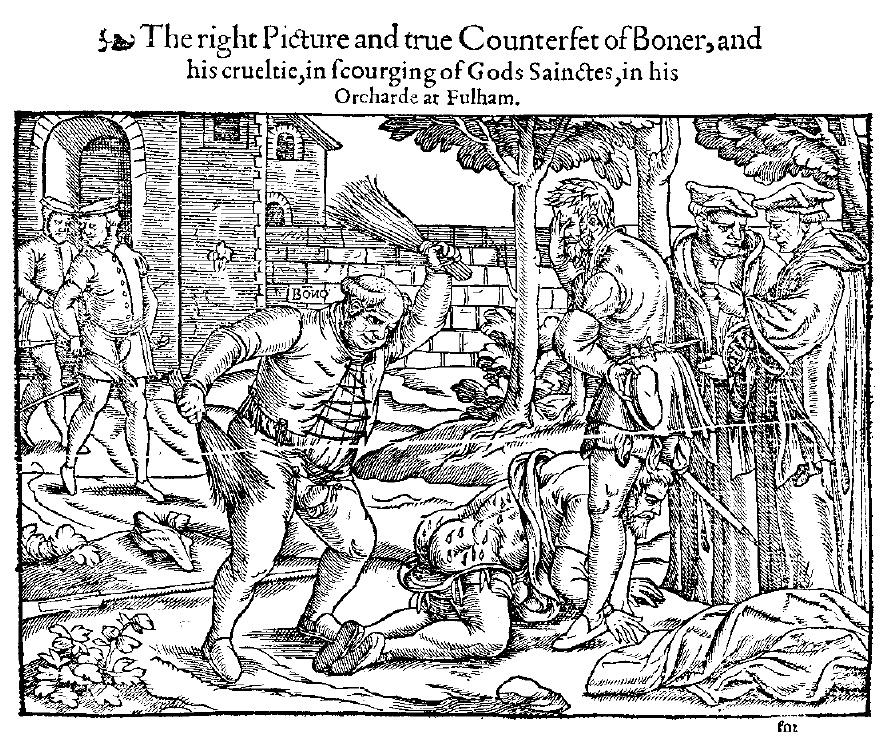
Figure 1. Woodcut depicting Edmund Bonner, bishop of